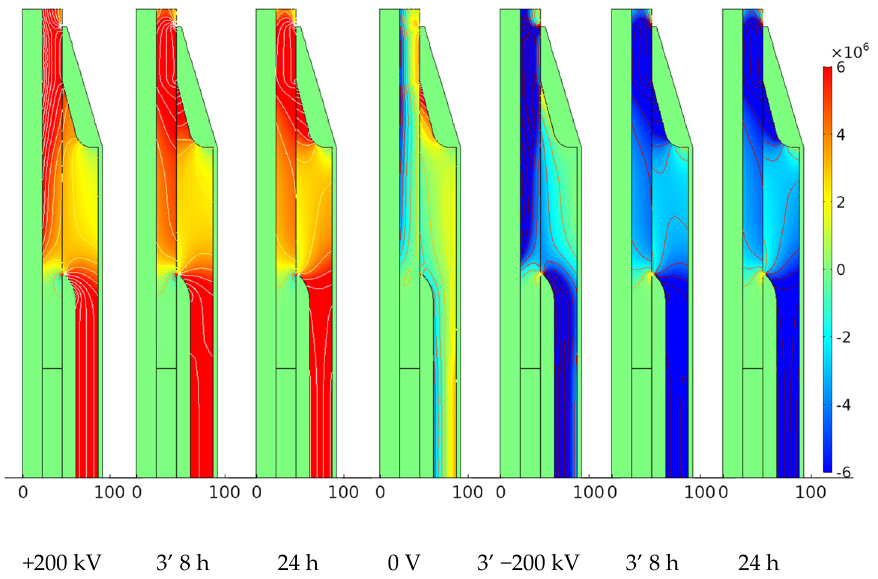
Figure 5. Examples of radial field maps in the joint after application of a current of 1 kA and voltage of +200 kV (t = 0) switched to − 200 kV after 24 h.